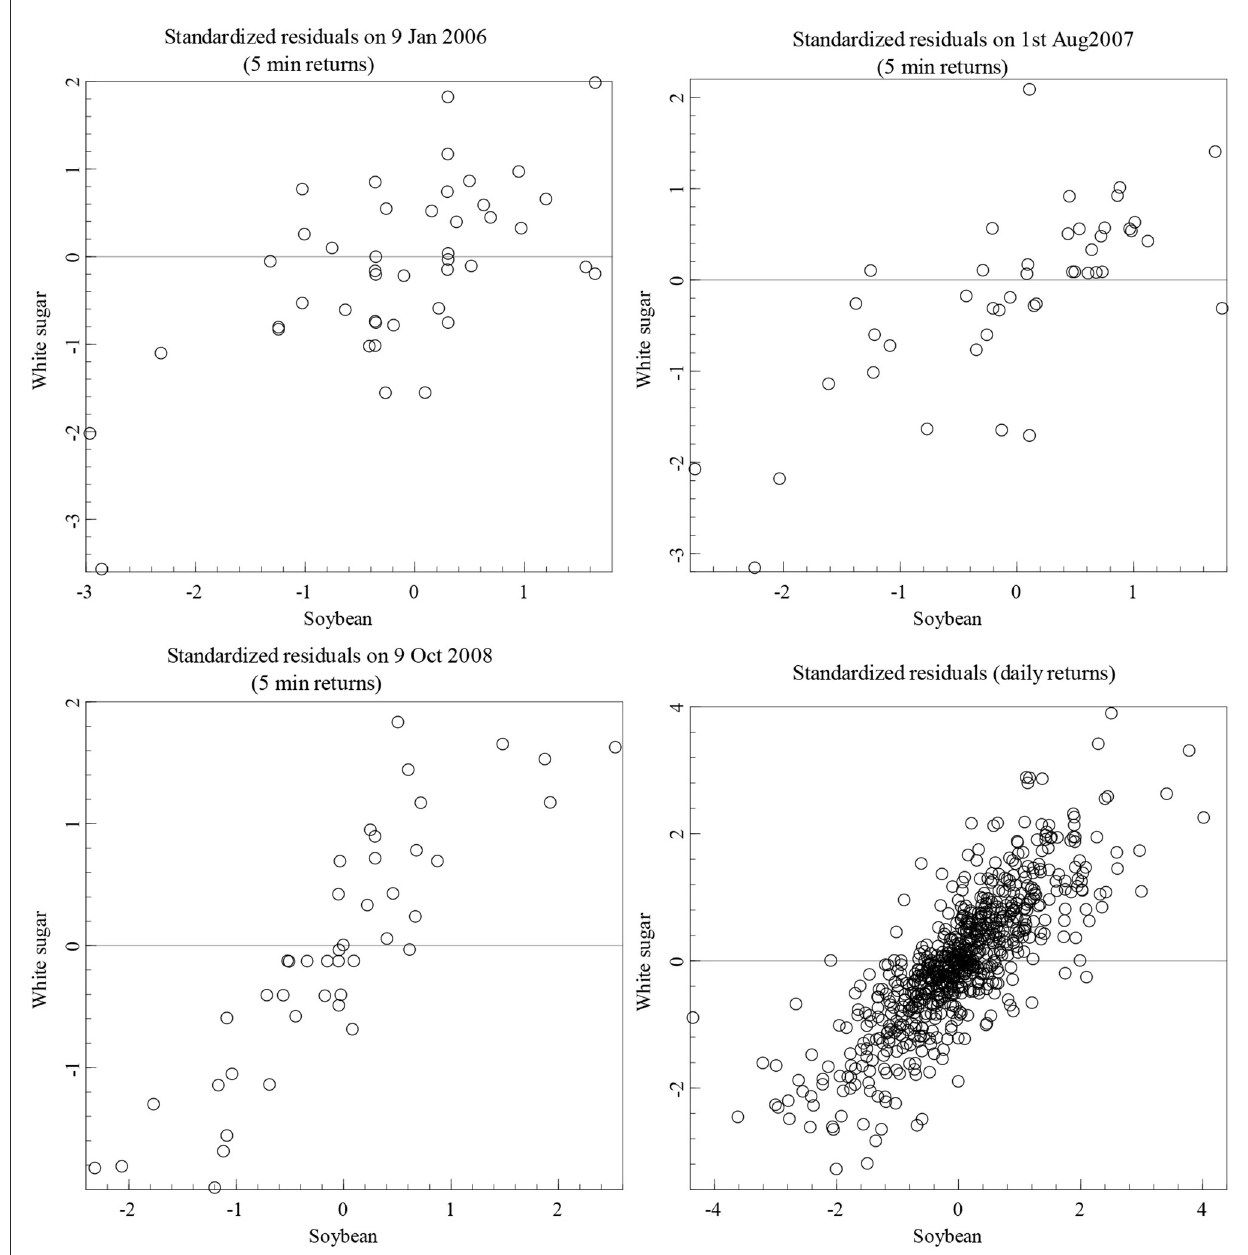
FIGURE4 Scatter plots of 5-min and daily residuals for white sugar-soybean pair.